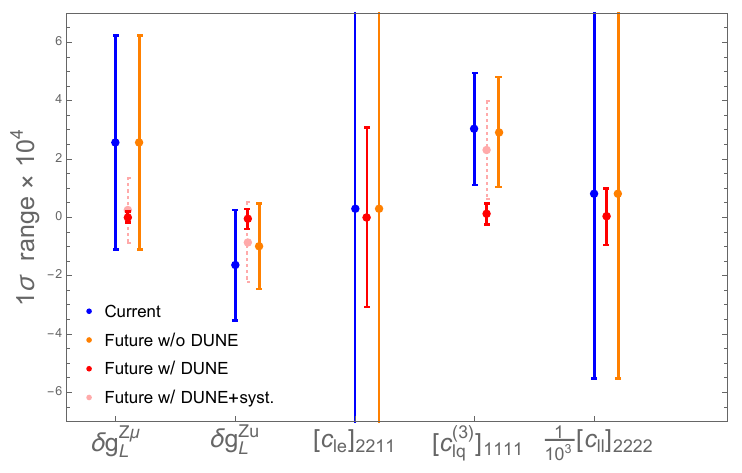
Figure 4 . 1 (cid:27) range for selected SMEFT Wilson coe(cid:14)cient from current and future low-energy precision measurements, assuming only one Wilson coe(cid:14)cient in the Higgs basis is non-zero at a time. The current constraints are represented by blue error bars. We future constraints are shown with the DUNE input assuming only statistical errors (red) or 0 : 1% systematic errors (dotted pink), and also without the DUNE input